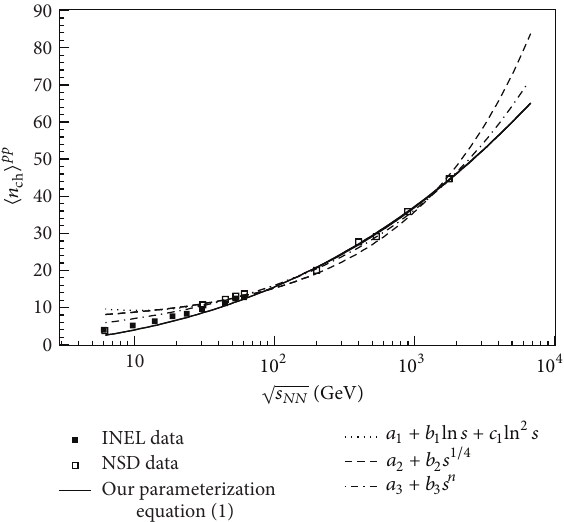
Figure 1: Variations of total mean multiplicities of charged hadrons ) produced in 𝑝 - 𝑝 collisions as a function of c.m. energy ( 𝑁 ch ( √𝑠 𝑁𝑁 ). Figure is taken from